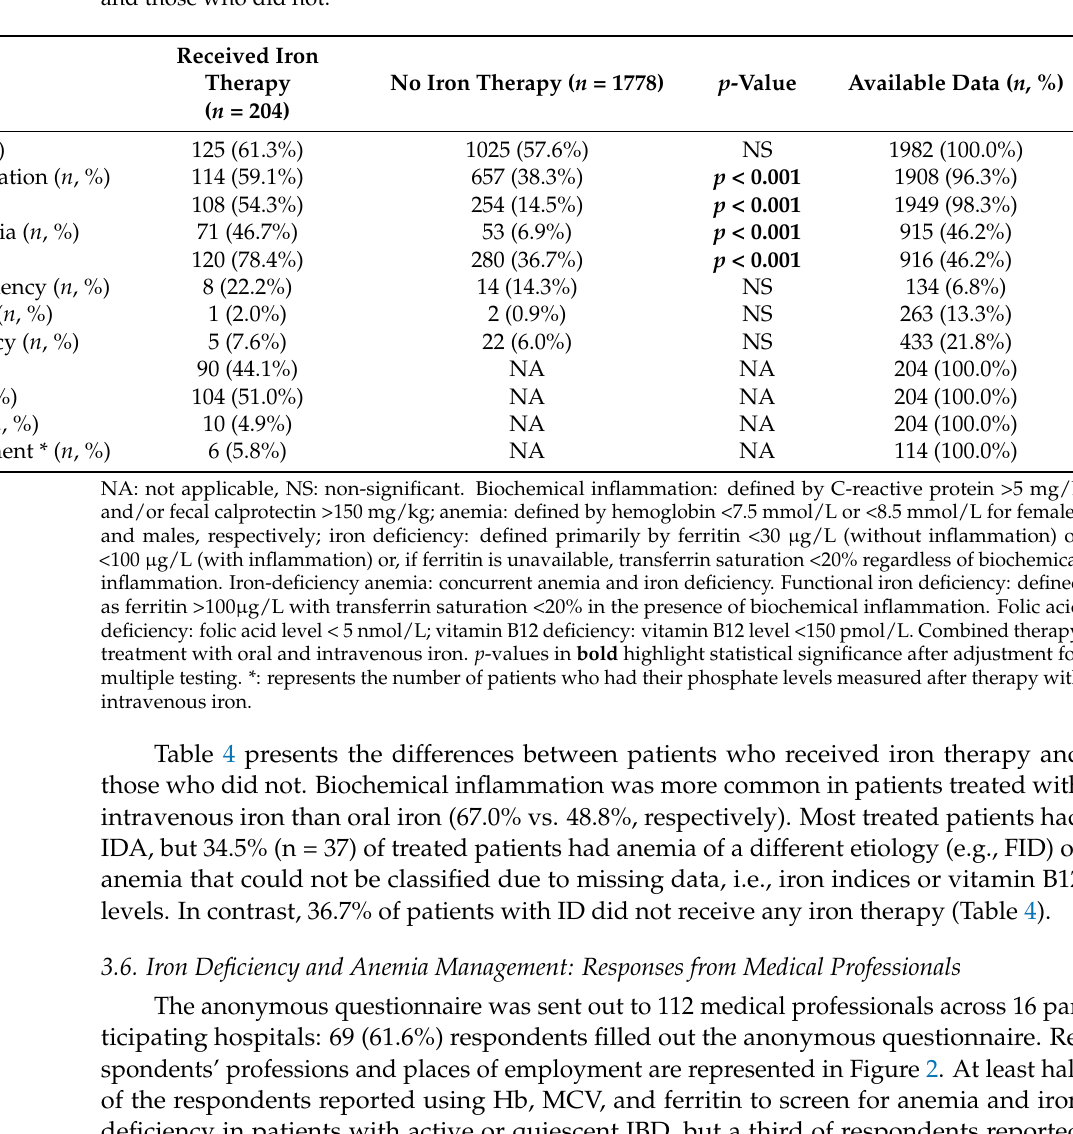
Table 4. Differences between patients with Inflammatory Bowel Disease who received iron therapy and those who did